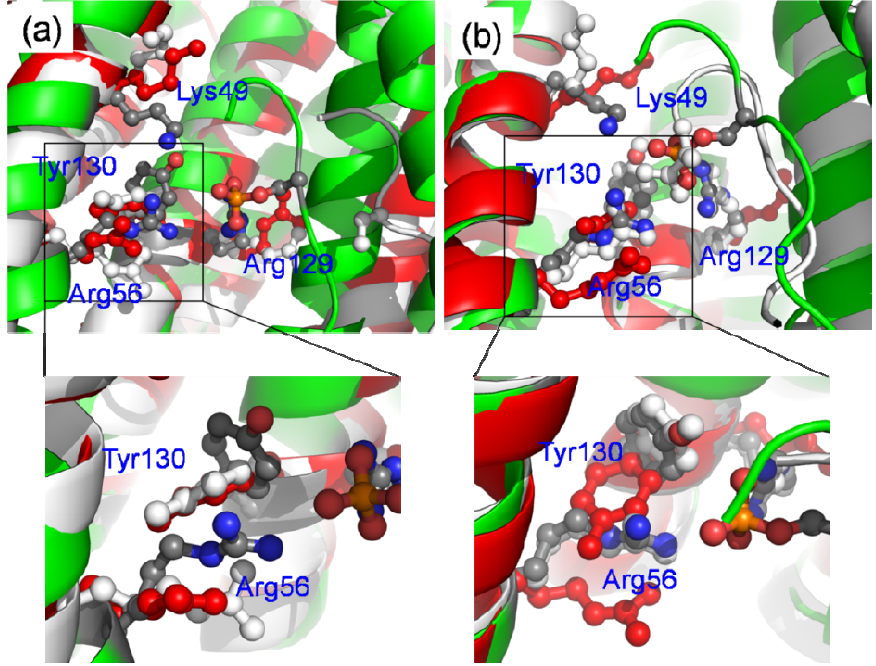
Figure 8. Superimposition of the key residues from the last structure for bound 14-3-3 σ , apo-14-3-3 σ and nop-14-3-3 σ . The proteins are shown in cartoon representation, apo-14-3-3 is shown in green color, bound 14-3-3 in red and nop-14-3-3 σ in white. The key residues are shown in ball and stick representation. ( a ) is for monomer A; ( b ) is for monomer